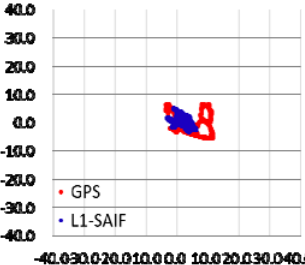
Figure 4. Positioning trajectory on the fixed point